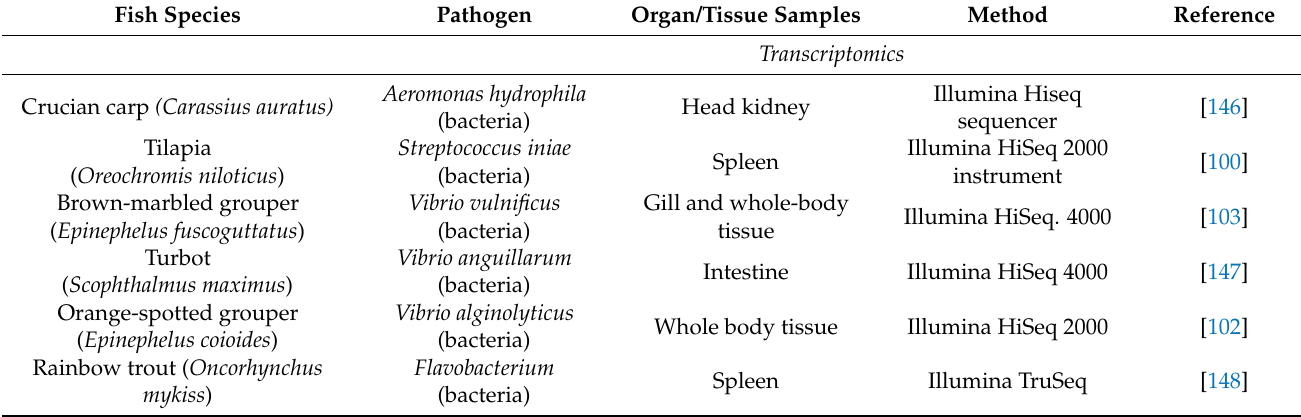
Table 2. Compilation of studies on fish immune response using various omics approaches. Fish